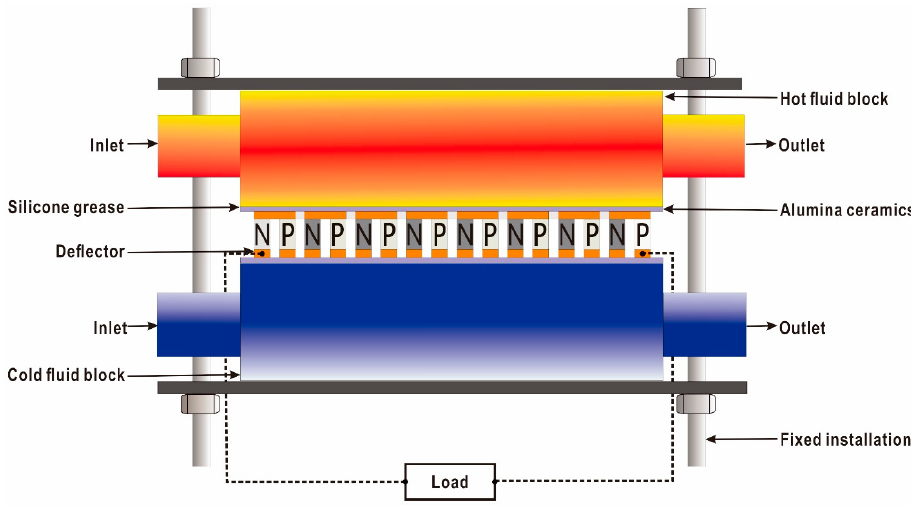
Figure 1. Schematic of the thermoelectric generator.